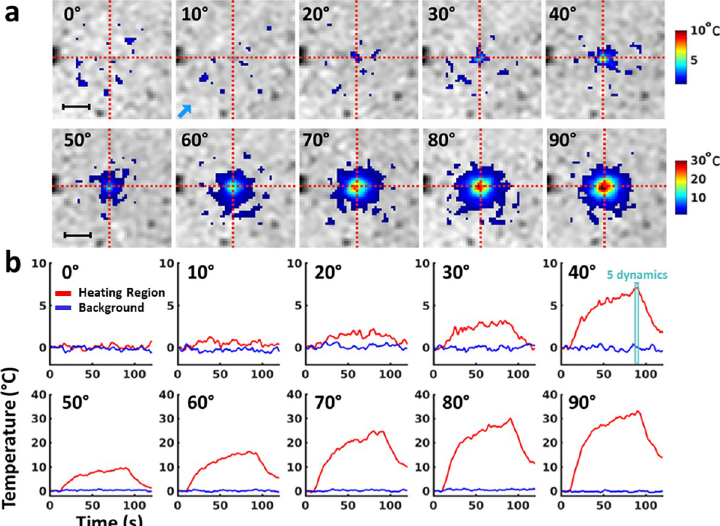
Fig 4. Evolution of temperature distribution with increasing flip angle: (a) unfiltered temperature maps are overlaid on their corresponding cropped magnitude images at the end of heating (acquisition #90) and show the temperature spatial distribution for each flip angle. Intersection of red lines indicates the pixel of interest and the blue arrow indicates the pixel selected for background, respectively. This pixel is the same for every acquisition and is located in the region of maximum heating. Horizontal bar in the top left images represents 1 cm. (b) Temperature evolution versus time for the pixel of interest. Red and blue curves show the temperature evolution in the pixel of interest and in a pixel outside the region of interest